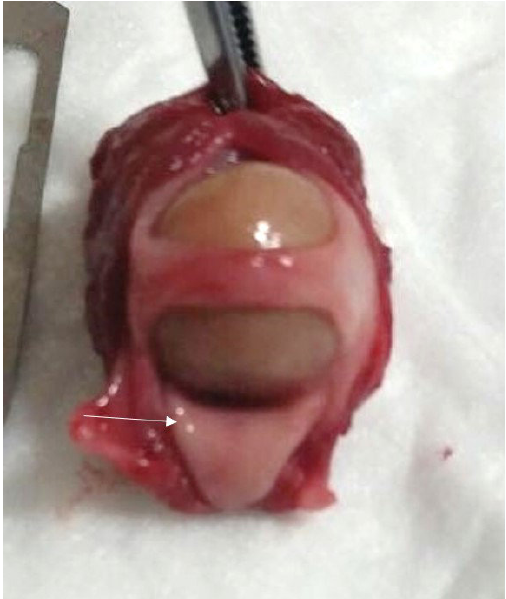
Figura 4. Fragmento de laringe evidenciado, massa de grandes dimensões deslocando ventralmente a cartilagem epiglote